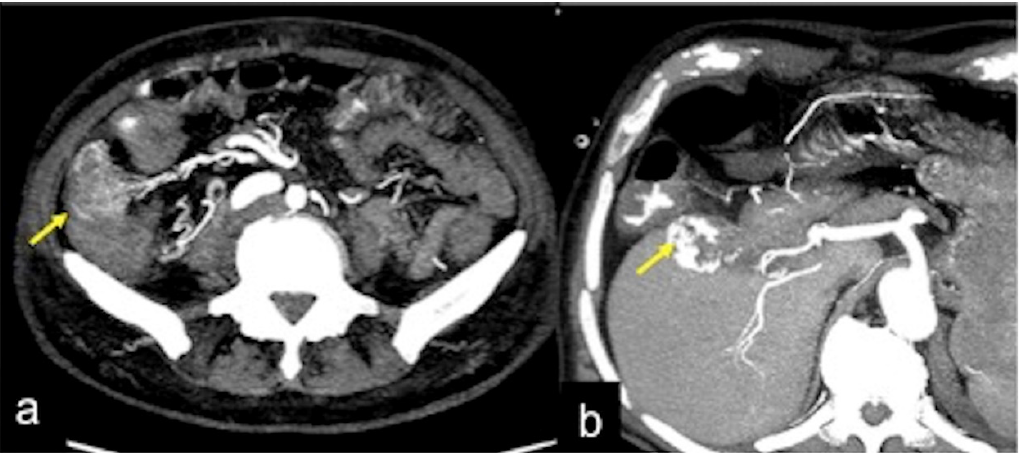
Figure 33. CTA multiphasic study in the arterial ( a ) and venous ( b ) phases of diverticular bleeding; a haemorrhagic spot in a diverticular sac of the colon at hepatic flexure is visible in the arterial phase (arrow ( a )) with increase and intensification in the venous phase (arrow ( b )).